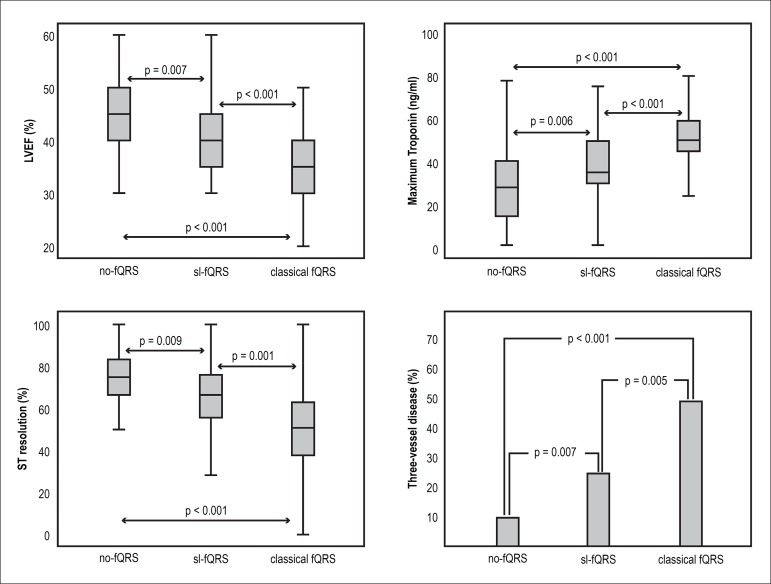
Comparisons among groups in terms of LVEF, maximum troponin, ST
resolution, and the frequency of three-vessel disease. LVEF: left
ventricular ejection fraction; fQRS: Fragmented QRS.